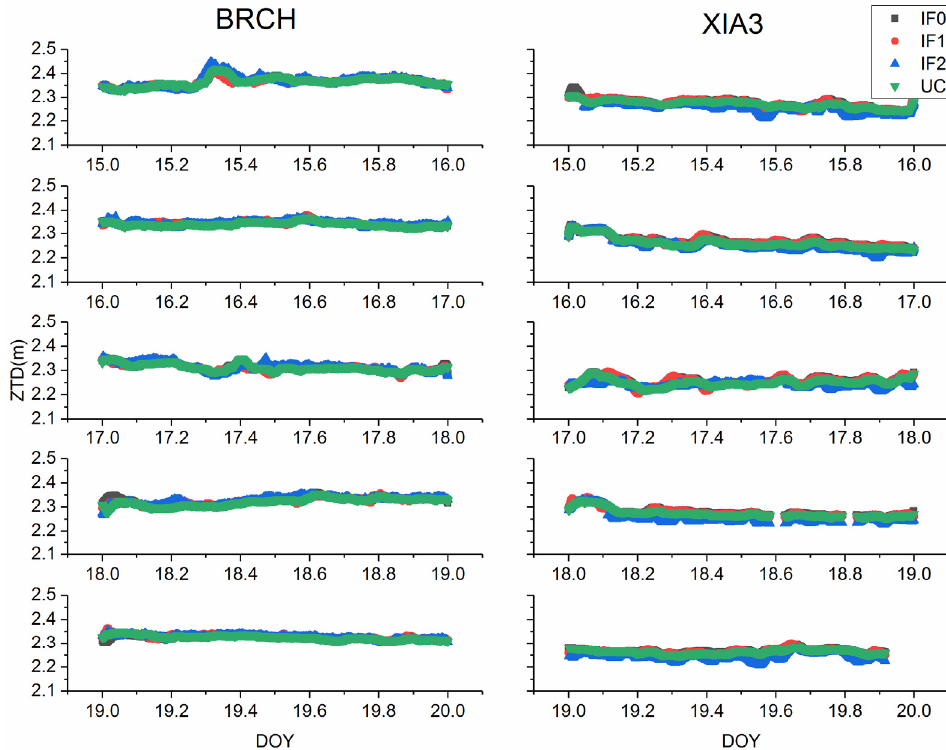
Figure 19. Zenith troposphere delay between different BDS-3 PPP methods.